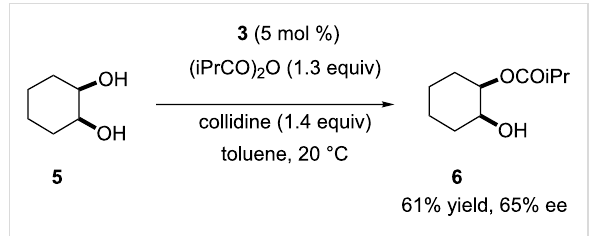
Scheme 1: Asymmetric desymmetrization of 5 with catalyst 3